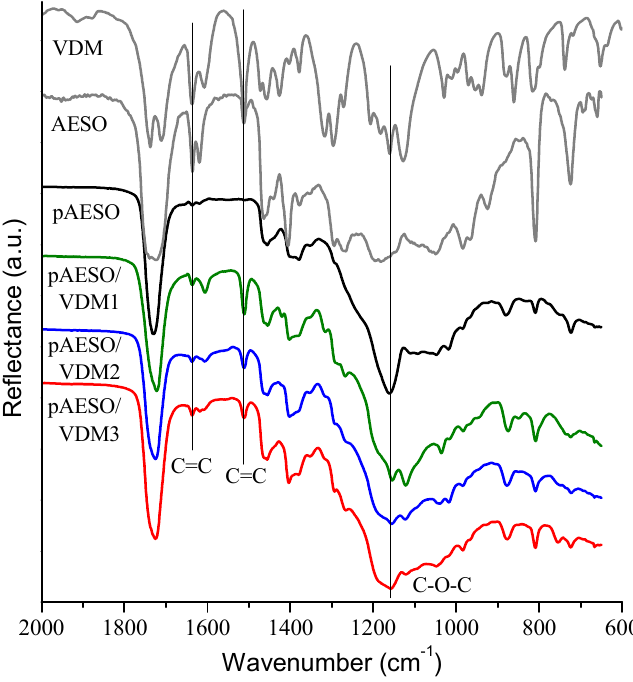
Figure 5. The FT-IR spectra of AESO, VDM, homopolymer pAESO and copolymer series pAESO/VDM.